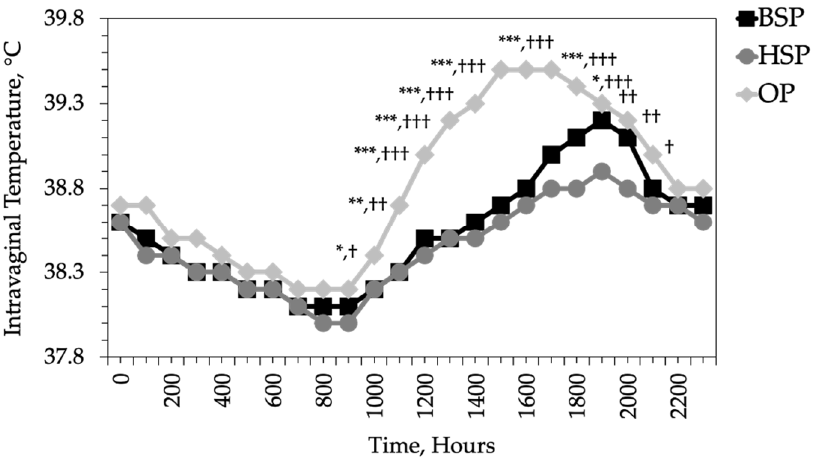
Figure 2. Mean vaginal temperatures (SE = 0.1) of Katahdin ewes by hour that grazed either open pasture (OP), black walnut silvopasture (BSP), or honeylocust silvopasture (HSP) treatments. * p